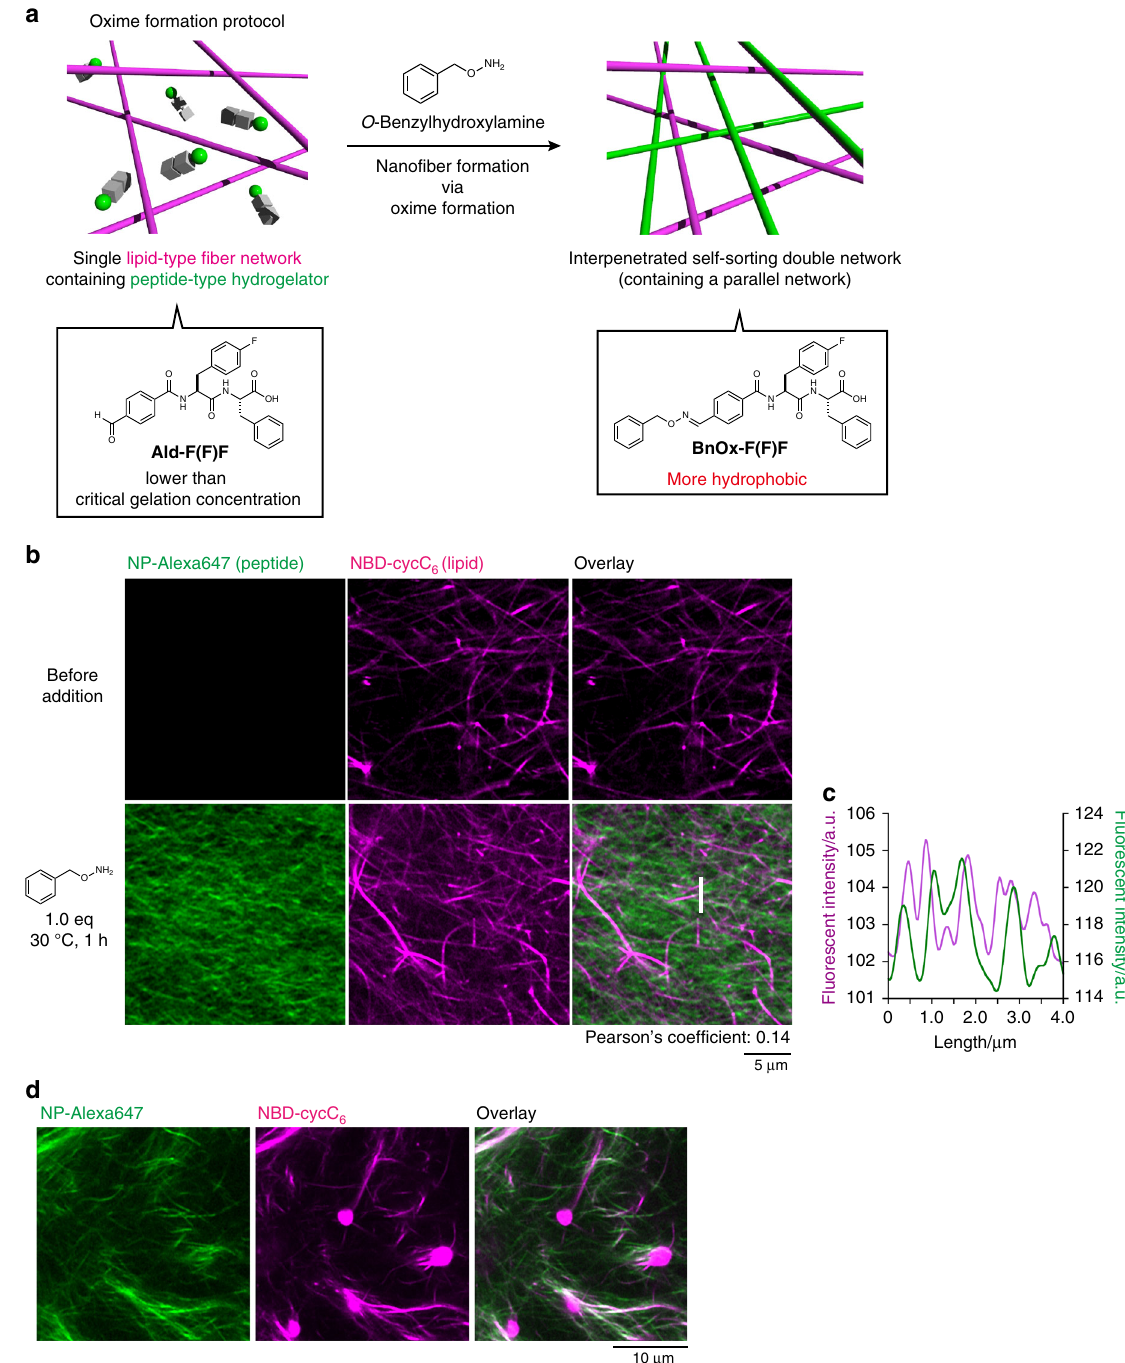
Fig. 3 Construction of the interpenetrated self-sorting network through the oxime formation protocol. a Schematic illustration of the construction of an interpenetrated self-sorting double network by the oxime formation protocol. b High-resolution Airyscan CLSM imaging (top) before and (bottom) 1 h after addition of O -benzylhydroxylamine. The peptide-type nano fi bers did not form upon buffer treatment (Supplementary Fig. 8). c Line plot analysis along a white line as shown in Fig. 3b. Condition: [ Ald-F(F)F ] = 4.3 mM (0.20 wt%), [ Phos-MecycC 5 ] = 2.4 mM (0.15 wt%), [ O -benzylhydroxylamine] = 4.3 mM (1.0 eq), [ NP-Alexa647 ] = 4.0 µ M, [ NBD-cycC 6 ] = 4.0 µ M, 100 mM MES, pH 6.0, 30 °C, 1 h. d High-resolution Airyscan CLSM imaging of a suspension of BnOx-F(F)F , Phos-MecycC 5 , NP-Alexa647 , and NBD-cycC 6 prepared by a heat-cool protocol. (Left) Alexa647 channel, (middle) NBD channel, (right) overlay image. Green: NP-Alexa647 , magenta: NBD-cycC 6 . Condition: [ BnOx-F(F)F ] = 4.3 mM (0.25wt%), [ Phos-MecycC 5 ] = 2.4 mM (0.15 wt%), [ NP- Alexa647 ] = 4.0 µ M, [ NBD-cycC 6 ] = 4.0 µ M, 100 mM MES, pH